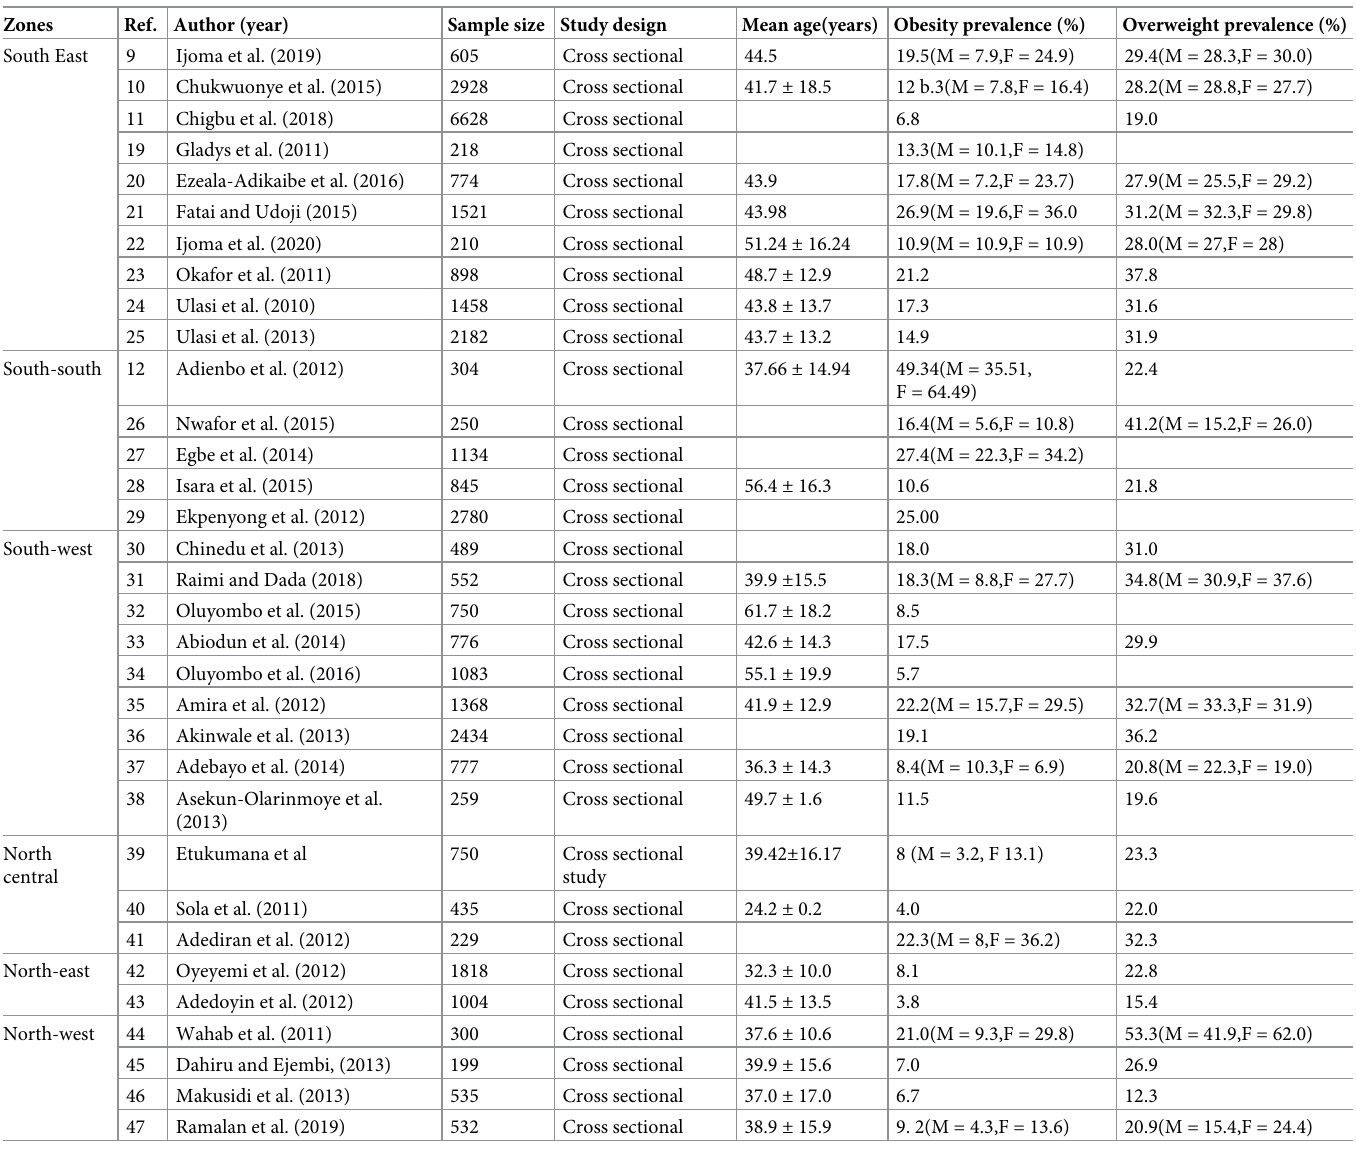
Table 1. The prevalence of overweight and obesity from population based studies in